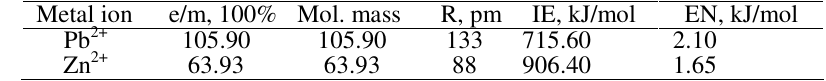
Table 6. Ionic character of Pb 2 and Zn